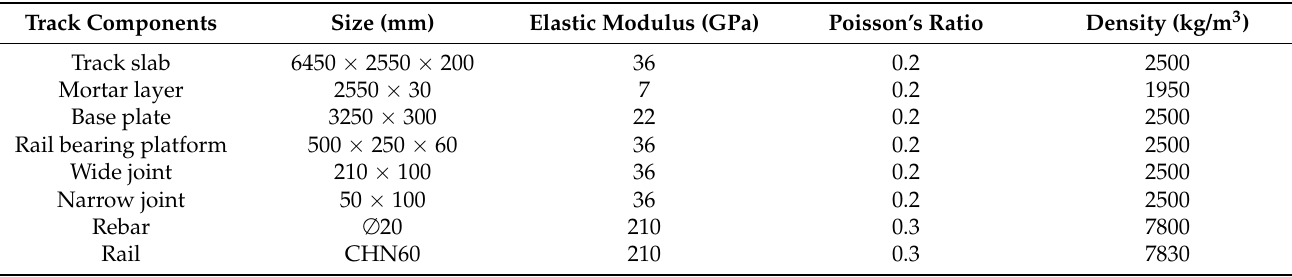
Table 1. Structural dimensions and material properties of track system.